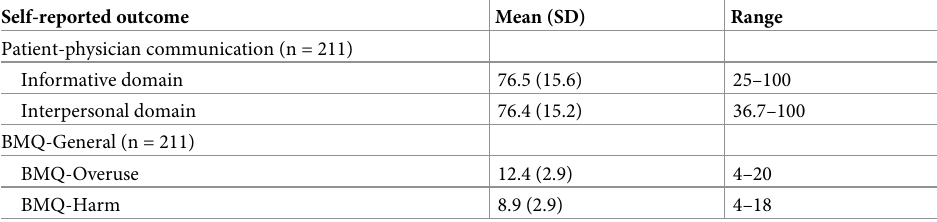
Table 3. Patient-reported